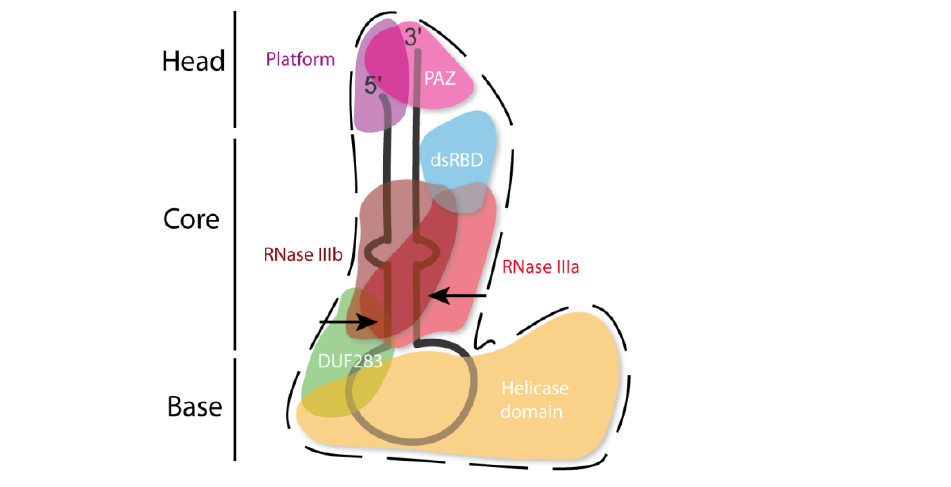
Figure 2. Scheme of the tertiary structure of hDicer in complex with pre-miRNA, prepared based on Liu et al. [49] . Arrows indicate the pre-miRNA cleavage sites by RNase III domains.